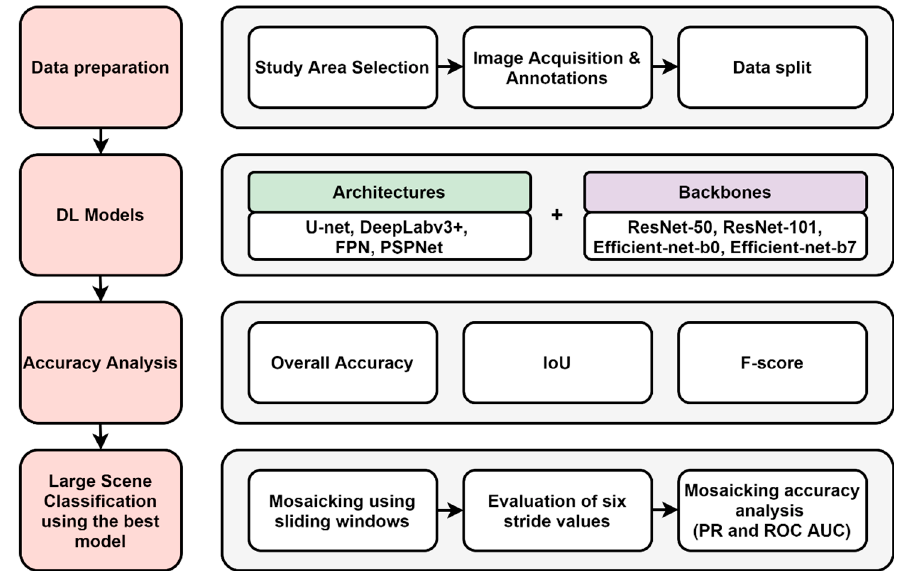
Figure 1. Methodological flowchart.